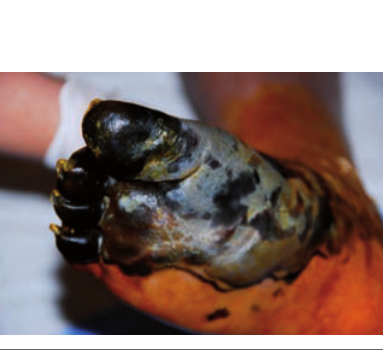
Figure 2. Lower extremity gangrene second- ary to both arterial and venous thrombosis.